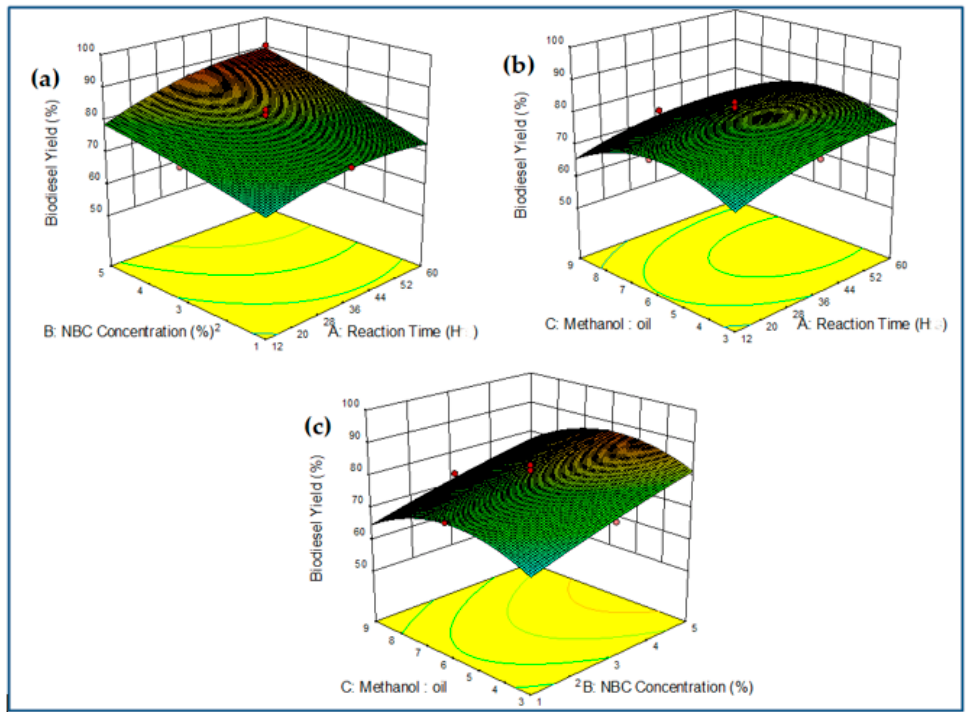
Figure 9. Response surface plots for significant interaction terms: ( a ) mutual effects of NBC3 concentration and reaction time on biodiesel yield, ( b ) mutual effects of reaction time and the methanol: oil ratio on biodiesel yield, ( c ) mutual effects of methanol: oil ratio and of NBC concentration on biodiesel yield.